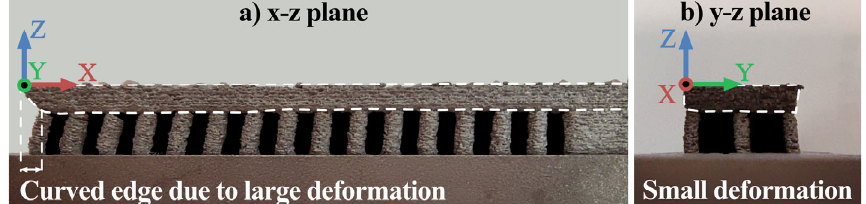
Figure 7. The deformation of the top panel for bidirectional S0R90 part, in ( a ) x ‐ axis and ( b ) y ‐ axis. As seen, large distortions could be observed along x ‐ axis while there is no significant distortion along the y ‐